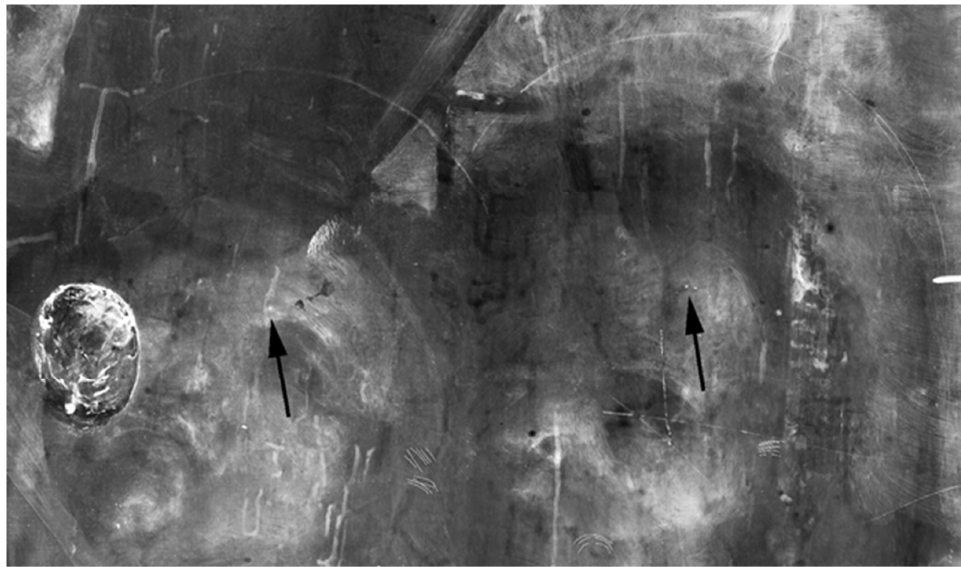
Figure 13. XR detail, where the signs of metal point engravings and needle points are evident in the tracing of the two haloes by means of a drawing compass.